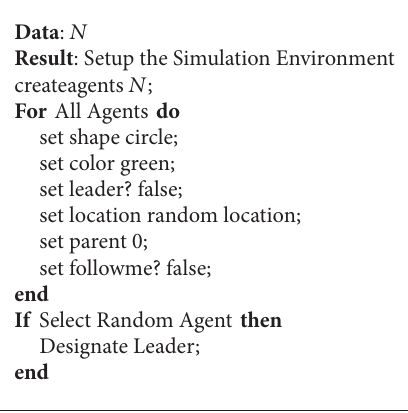
Algorithm 1: Setting up the simulation environment.